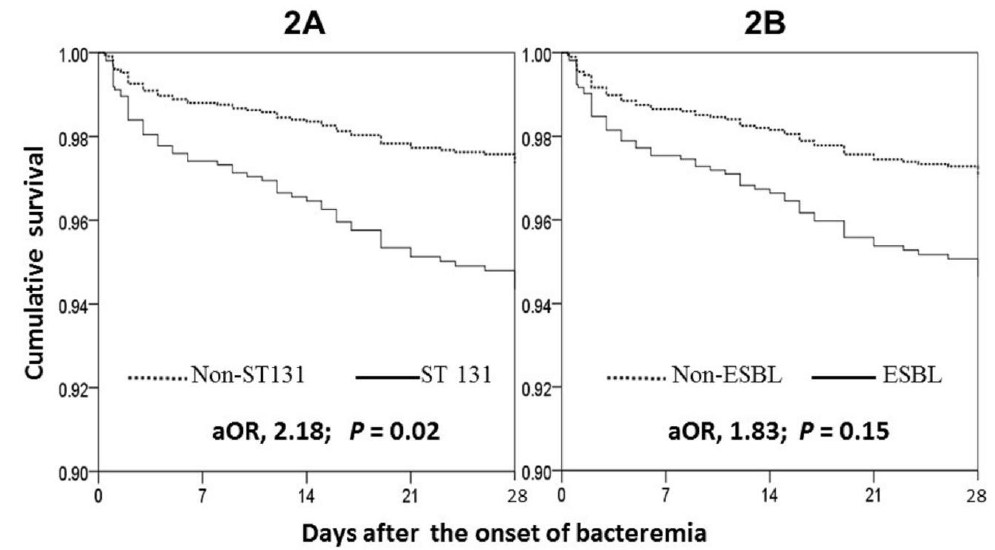
Figure 2. Survival curves of the cases of community-onset Escherichia coli bacteremia due to ST131 or non-ST131 isolates ( 2A ), and the isolates with or without ESBL production ( 2B ) in the Cox regression after adjustment of independent predictors of 28-day mortality *. aOR: adjusted odds ratio. * Includes fatal comorbidity (McCabe classification), Pitt bacteremia score ≥ 4 at bacteremia onset, inappropriate empirical antimicrobial therapy, bacteremia due to pneumonia or soft-tissue infections, underlying liver cirrhosis, and nursing home residence.